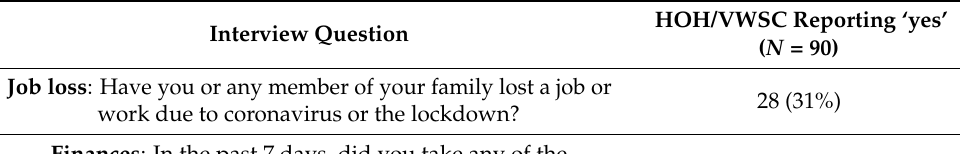
HOH/VWSC Reporting